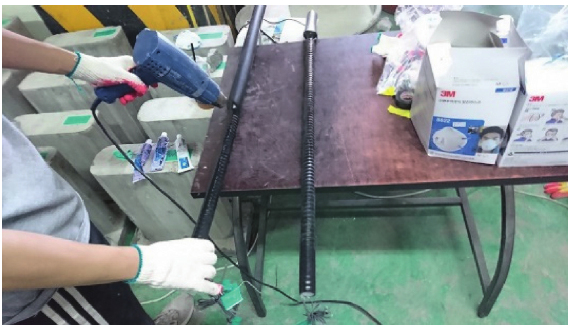
Figure 9: Coating GFRP rock bolt sensor with heat-shrink